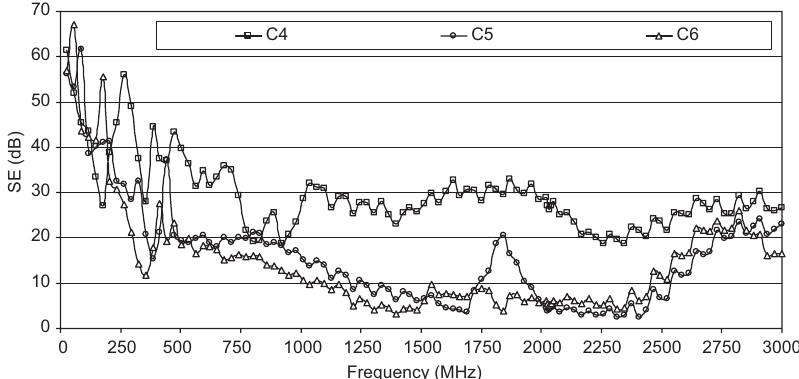
Figure 7 EMSE values of C4 to C6 composite laminates.